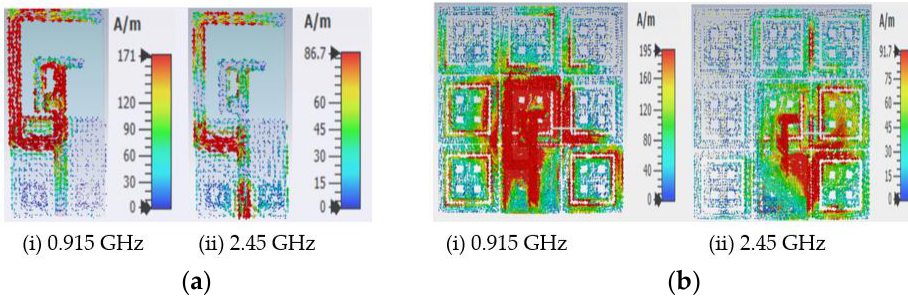
Figure 21. Current distribution characteristics, ( a ) antenna without AMC Backing, ( b ) antenna with AMC Backing.